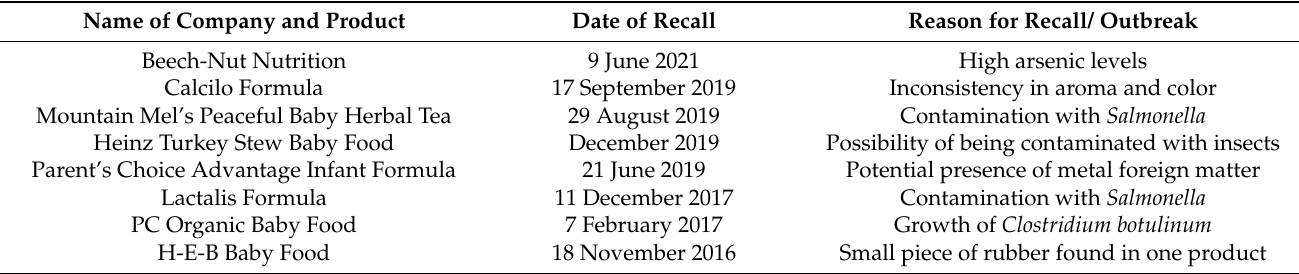
Table 2. List of recent infant formula and complementary food recall outbreaks and the possible causes